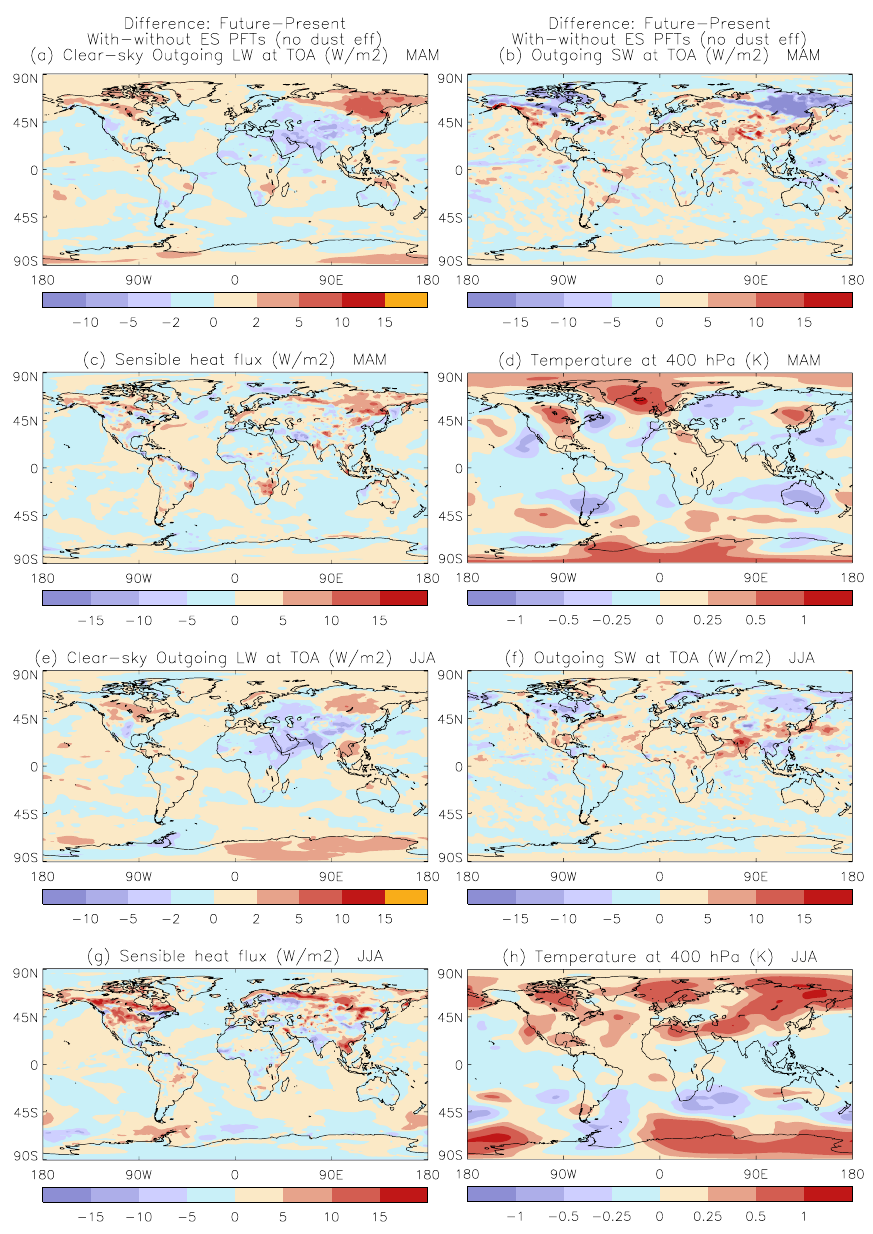
Fig. 18. As Fig. 16 but showing the impact of the ES land cover on the future-present differences (with no dust radiative